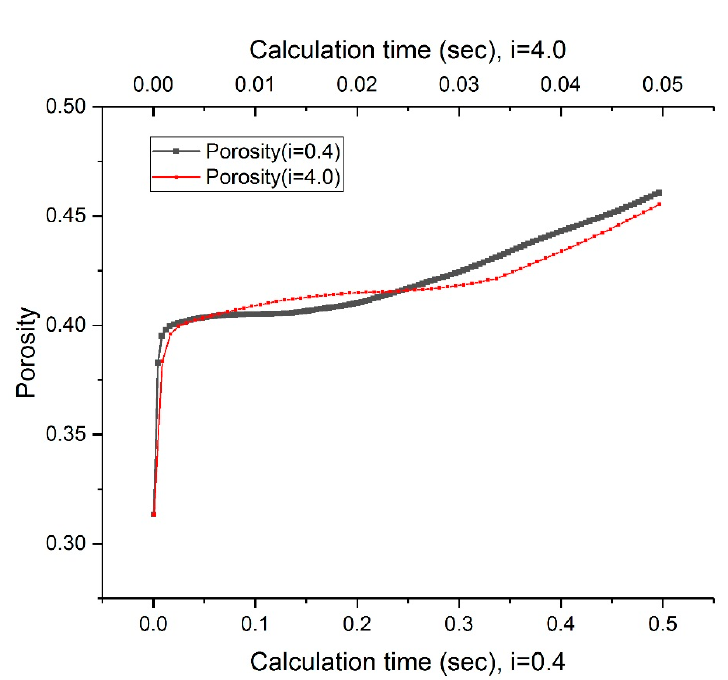
ff erent hydraulic